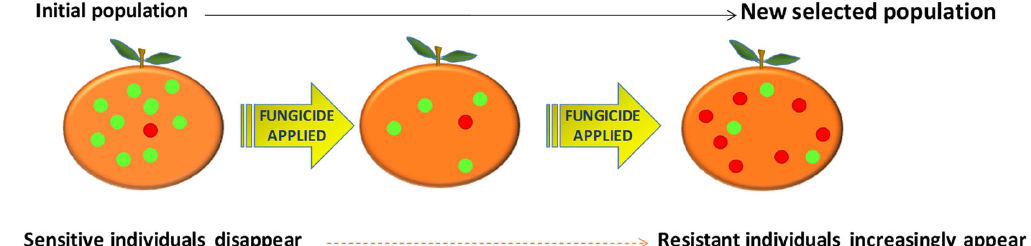
Figure 2. A diagram of the evolution of resistance to fungicides. This graphic shows an example of how selection pressure may take place. Initial population with little resistance evolves until resistance becomes widespread due to repeated fungicide applications. Adapted from Deising et al. [18].